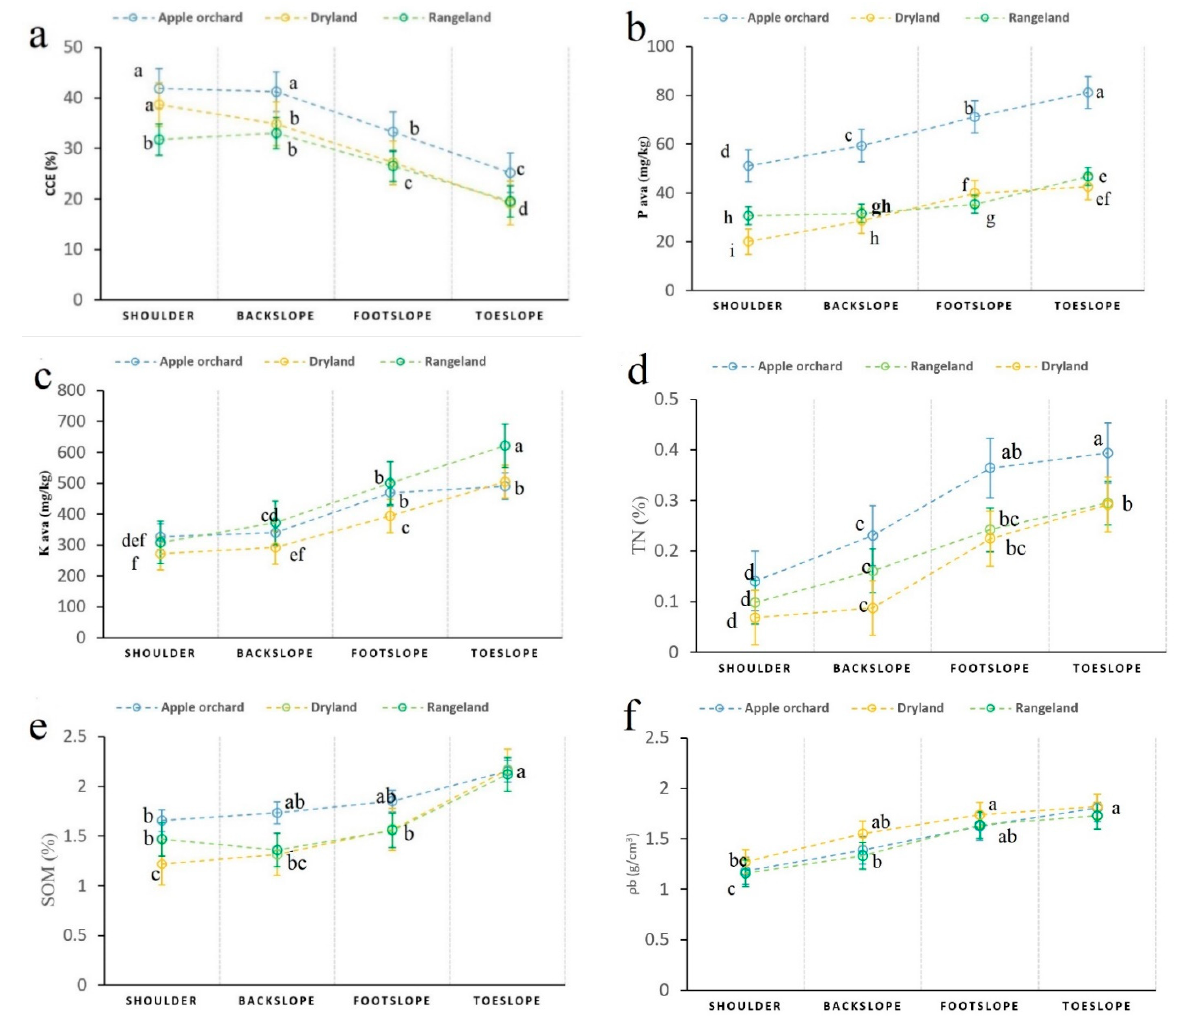
Figure 3. Variability of some soil properties at a 0–30 cm depth in various land uses at four slope positions in the study area: ( a ) CCE (calcium carbonate equivalent), TN: total nitrogen; ( b ) P ava (available phosphorus); ( c ) K ava (available phosphorus), ( d ) TN (total nitrogen); ( e ) SOM (soil organic matter); ( f ) ρ b (bulk density). Means ( n = 24) with the same letter are significantly different using the least significant difference (LSD) test at p <